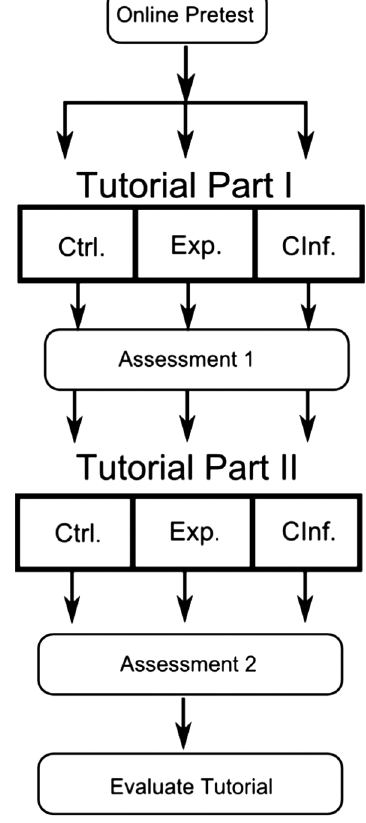
FIG. 9. Procedural outline of the